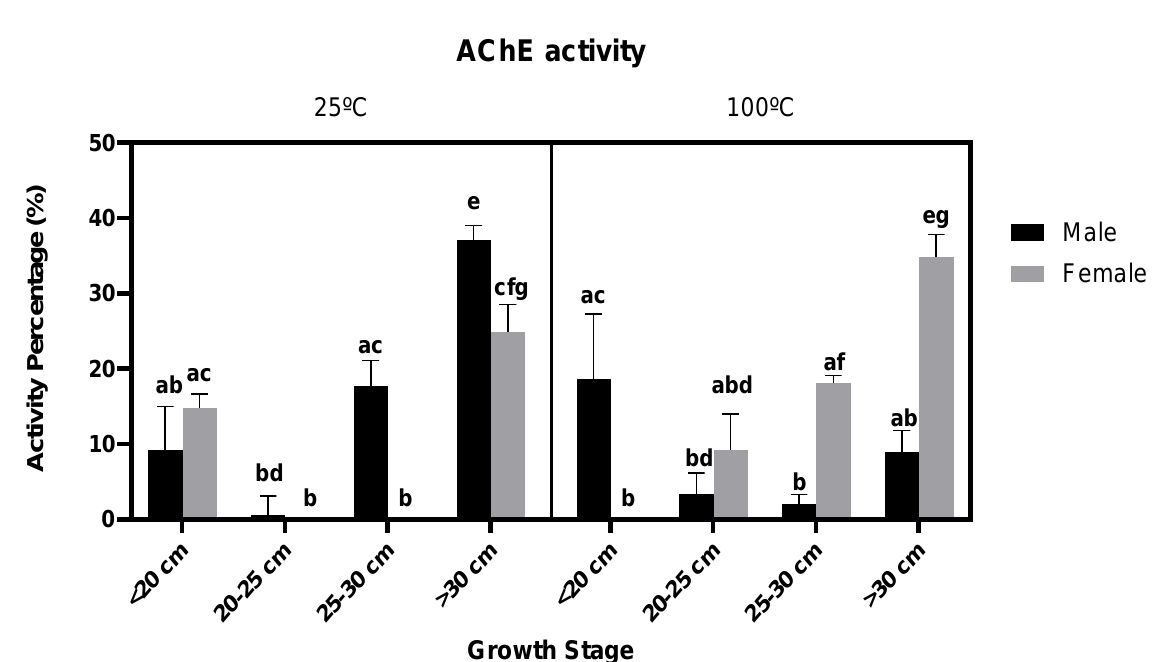
Figure 3. Effect on the AChE activity, percentage of inhibition of different F. vesiculosus extracts according to their gender, growth stage and temperature of extraction (25 °C and 100 °C at 1 mg/mL). Different superscript letters (a–g) correspond to values that can be considered statistically different ( p -value ≤ 0.05). A three-way ANOVA was carried out for the statistical analysis between gender, growth stage and temperature of extraction with Tukey’s HSD test for multiple comparisons, represented by superscripted letters.